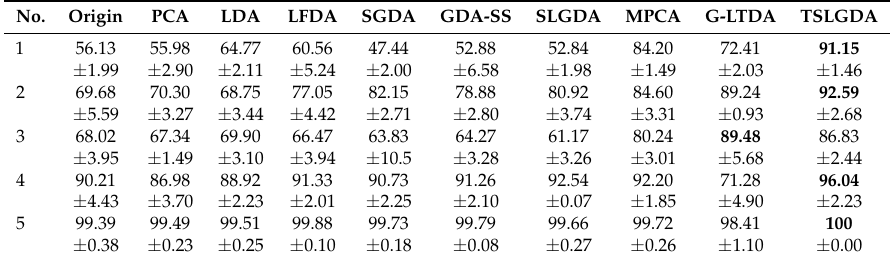
Table 4. Classification accuracy (%) and standard deviation of different methods for the University of Pavia data when the reduced dimension is